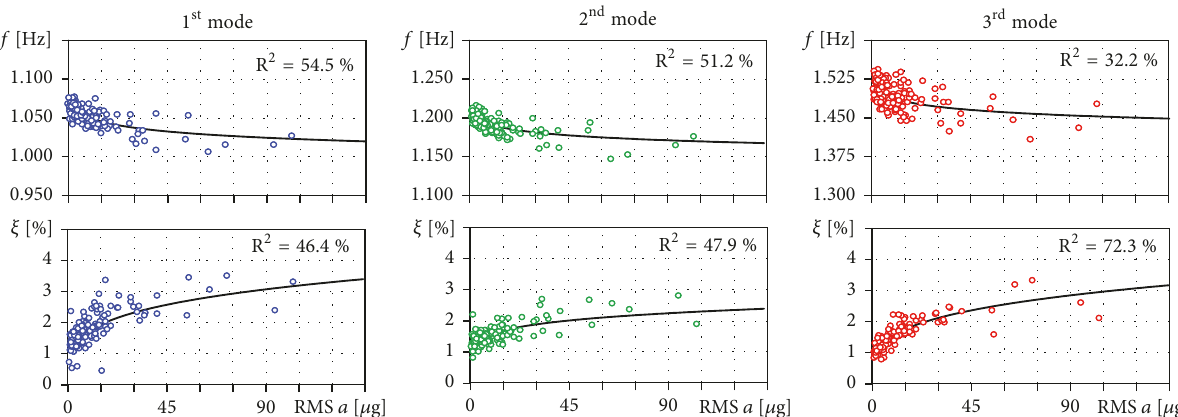
Figure 14: Variation of frequencies and damping ratios with respect to the amplitude of the measured acceleration